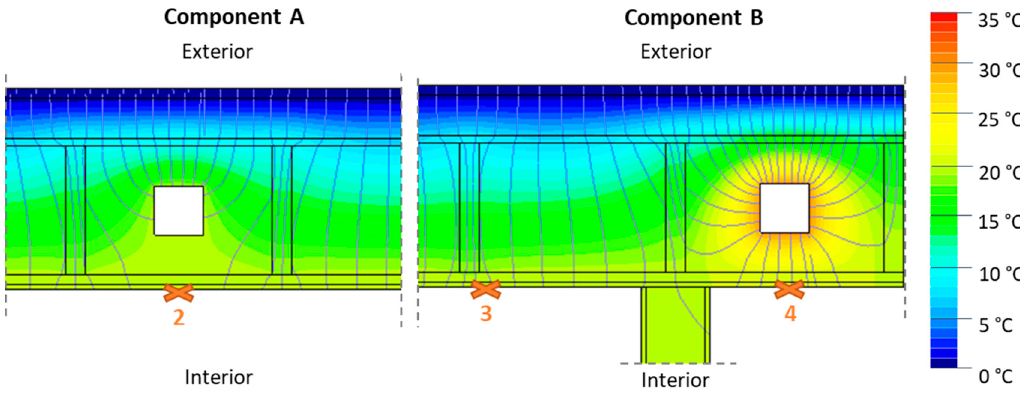
Figure 7. Simulation of the temperature variance and isoflux-lines of the post-retrofit rear facade by means of TRISCO.